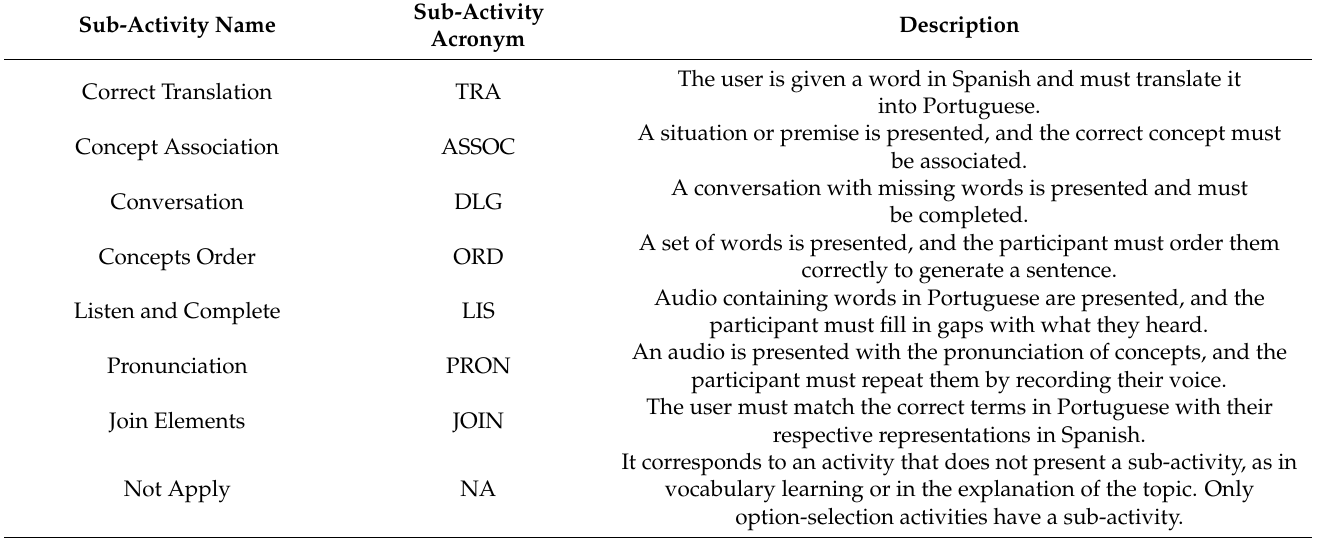
Table 2. Categories of sub-activities.